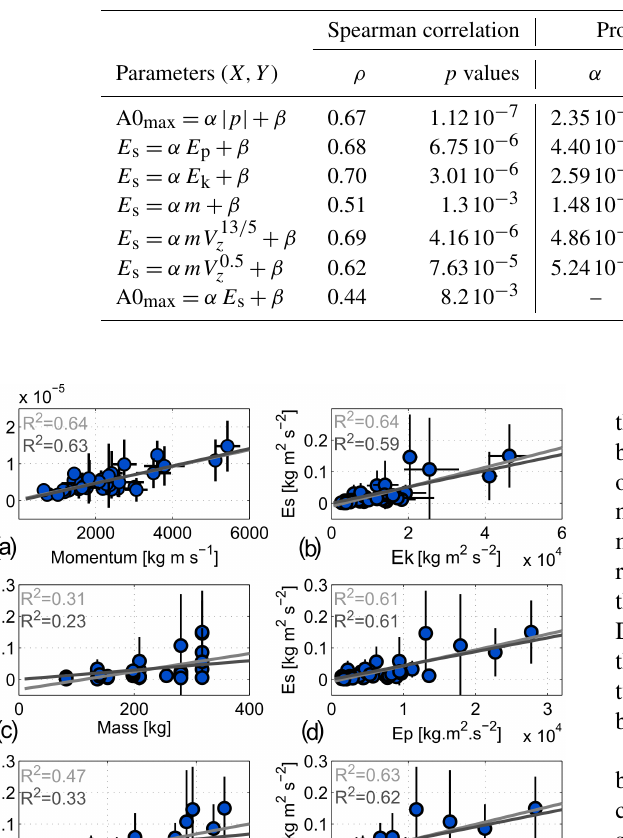
Table 1. Spearman correlation coefficients, coefficients of the regression lines for proportional and linear relationships and corresponding coefficient of determination R 2 .